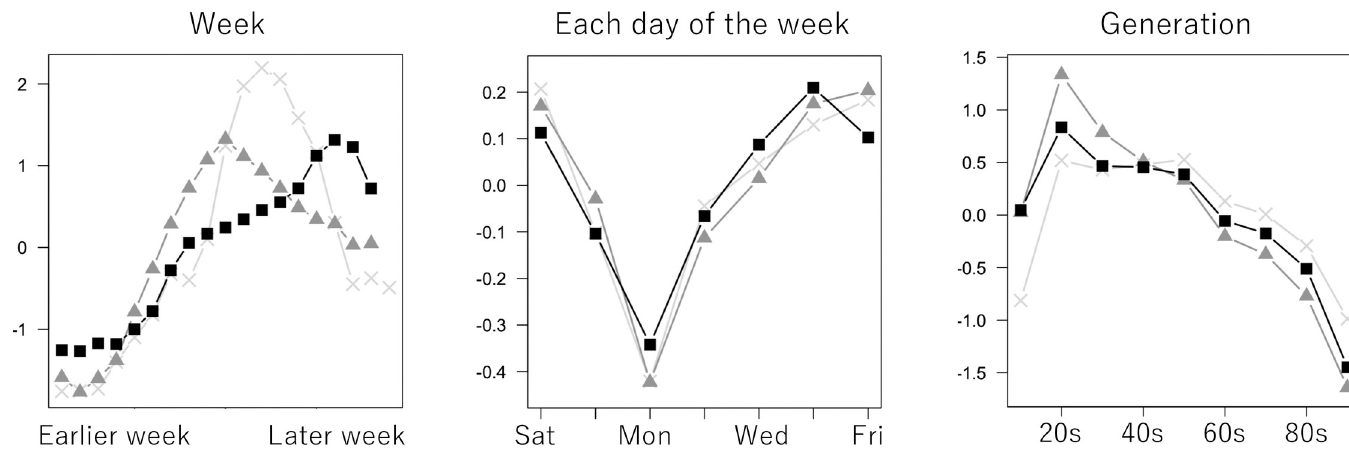
Fig 16. Estimated group effects (week, days of the week, generation).